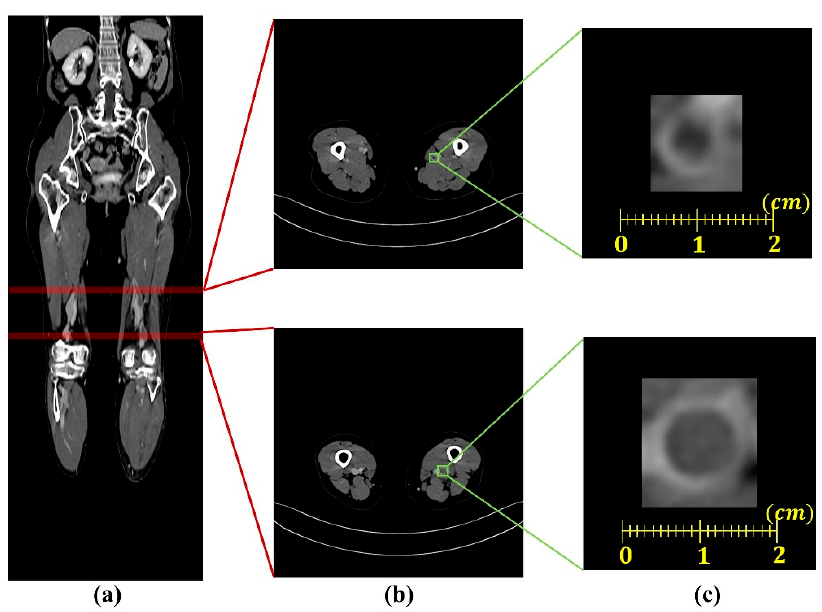
Figure 2. Example of generating the vein region image containing thrombus: ( a ) a contrast-enhanced lower extremity computed tomography venography image in coronal view; ( b ) computed tomography venography images containing thrombus; ( c ) generated vein region image from ( b ).